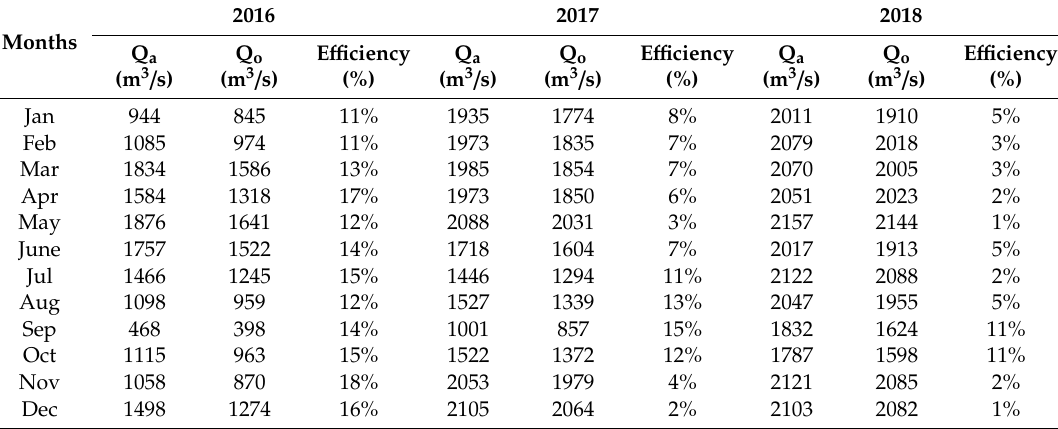
Table 2. Power generation flow results of Baluchaung II hydropower station.